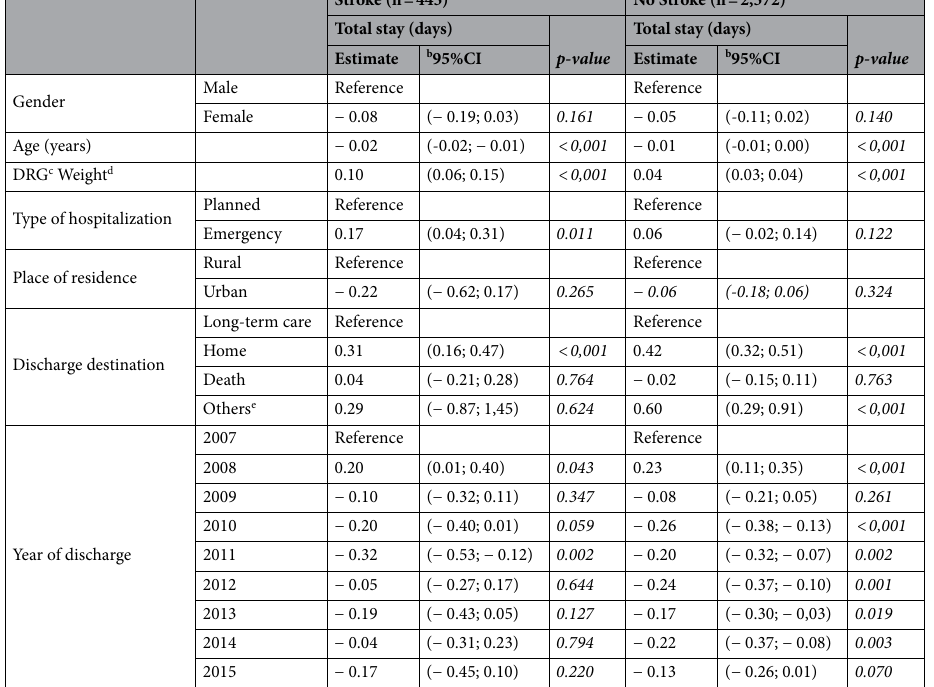
Table 3. Relationship between LOS a by patient characteristics and context of care in patients with stroke and delayed discharge for non-clinical reasons: univariate analyses. Cantabria (Northern Spain), 2007–2015. a LOS: length of total stay; b 95%CI, 95% confidence interval; c DRG, diagnosis-related group; d DRG weight, complexity in terms of consumption of hospital resources for care provision, based on the average annual cost of hospitalization in acute care units (weight = 1); e nursing homes for people with